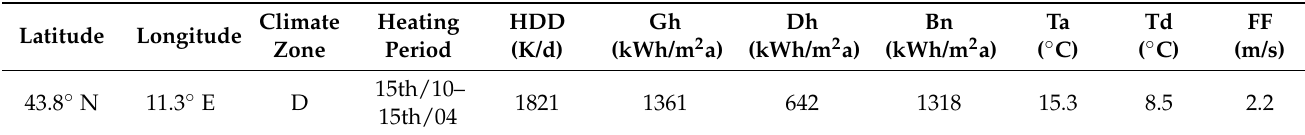
Table 2. Climate data for Florence. In the table: HDD means Heating Degree Days, GH stands for Global Horizontal Radiation, Dh means Diffuse Radiation, Bn means Direct Normal Radiation, Ta stands for Air Temperature, Td stands for Dewpoint Temperature and FF indicates wind speed. The climate data are annual